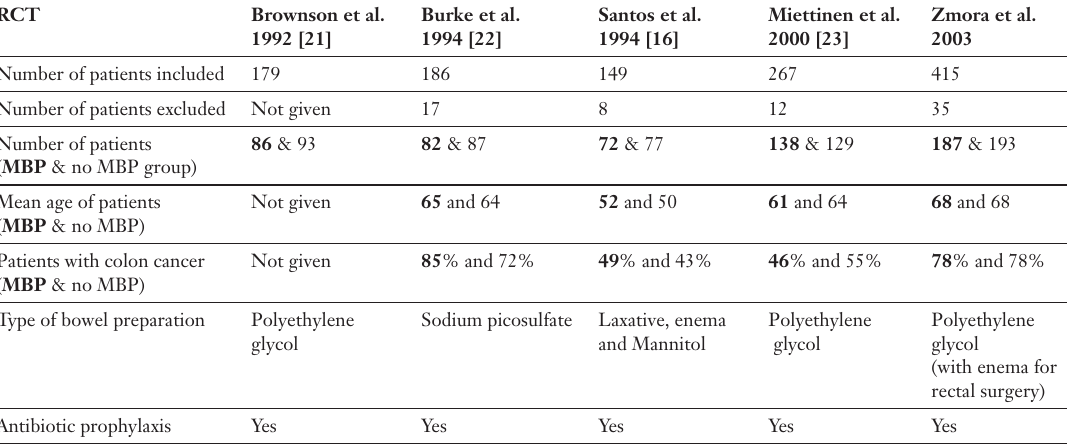
Randomised prospective trials evaluating mechani- cal bowel preparation in elective colorectal